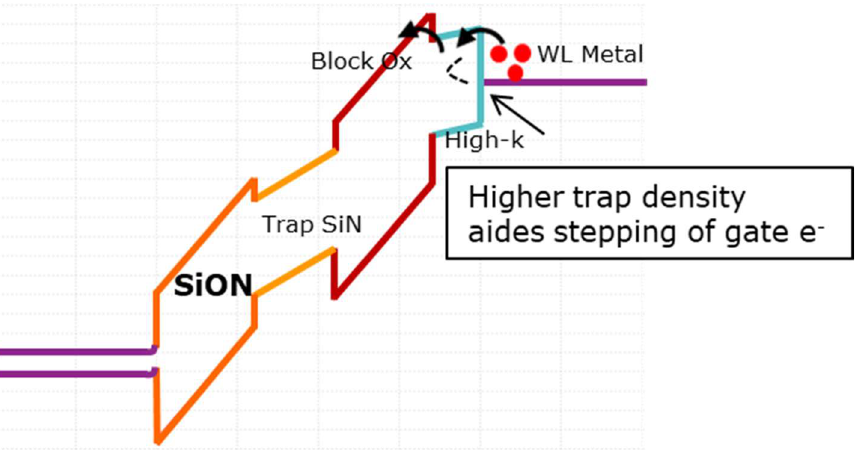
Figure 14. A typical band diagram of MHONOS during erase. Higher trap density reduces the tunneling path for gate electrons resulting in poor erase.